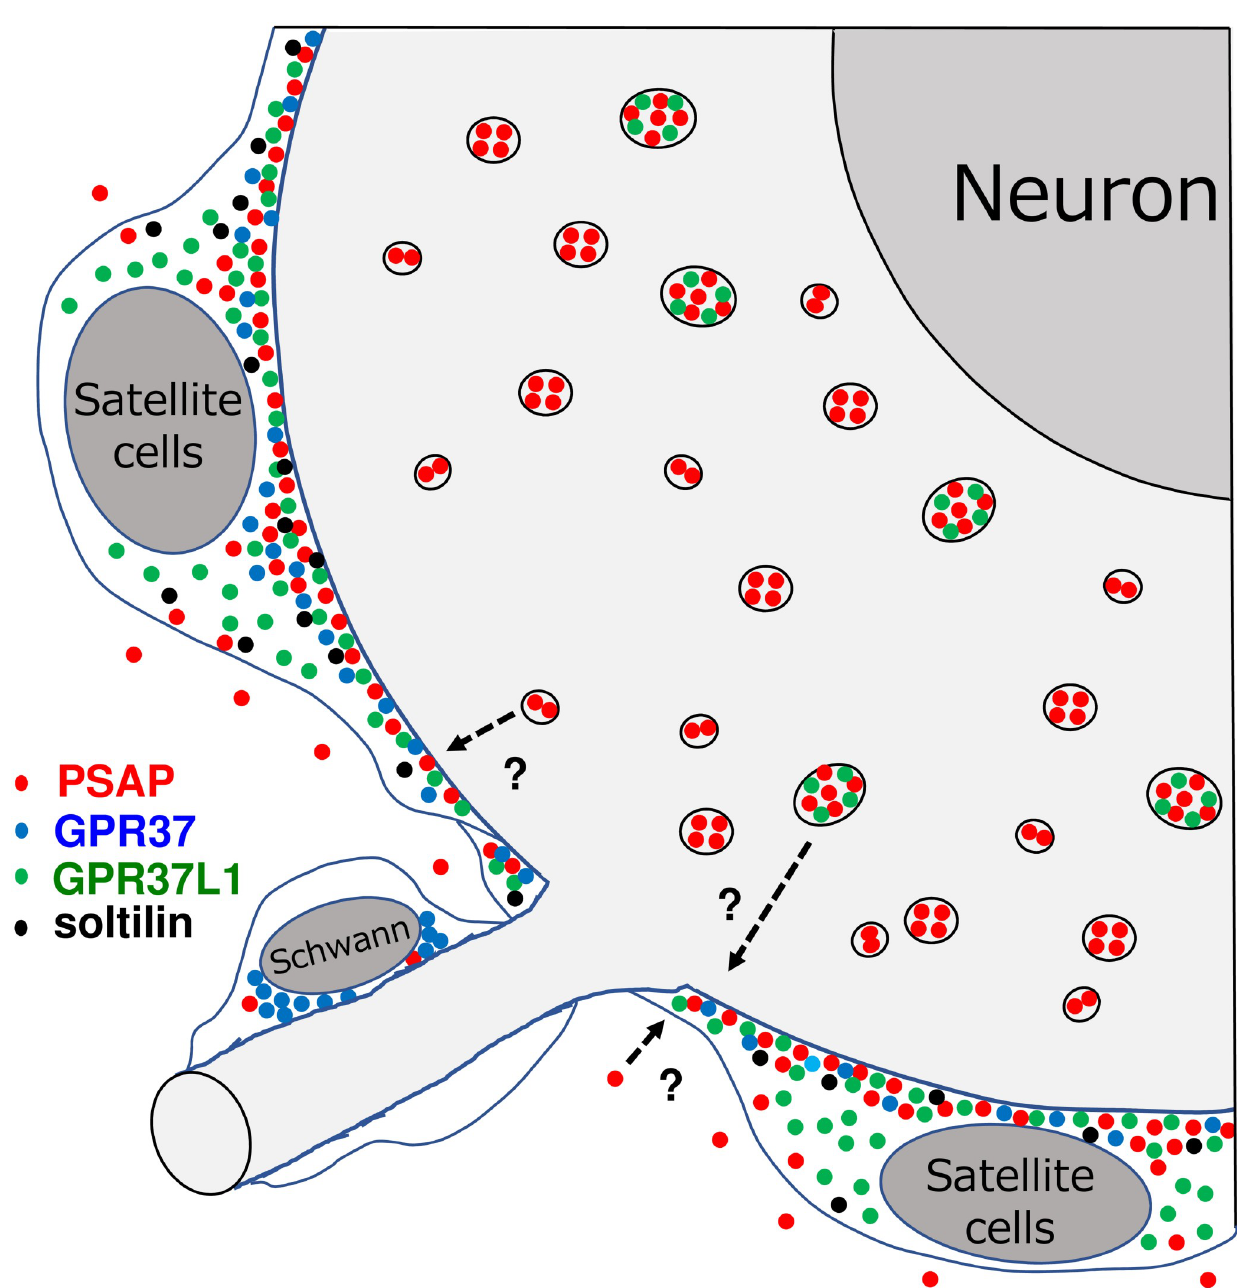
Fig 11. Schematic drawing of the interactions between neurons and satellite cells in the developing DRG. DRG neurons produced and contained PSAP in lysosomes with or without GPR37L1. At approximately 8 weeks, the satellite cells around larger neurons showed dispersed PSAP colocalized with both receptors near the neuron boundary. Sortilin, not shown in this figure, was observed at an earlier stage (2–4 weeks), and always colocalized with GPR37L1. In conclusion, DRG neurons produce PSAP, which may be delivered to satellite cells in a paracrine manner. It is also plausible that satellite cells take up PSAP from their surrounding extracellular space and transport PSAP to neurons. GPR37L1 and sortilin may transport PSAP to stimulate the proliferation or maturation of satellite